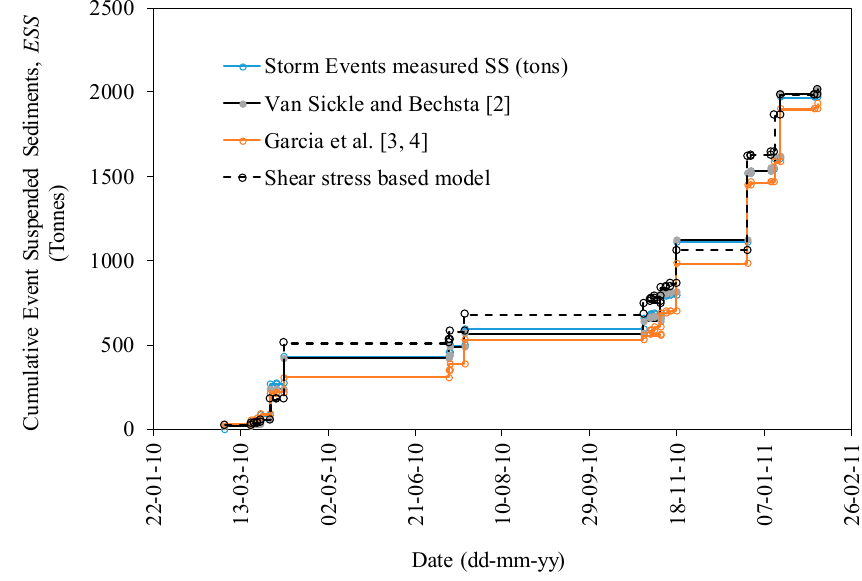
Figure 12. Cumulative event suspended sediment (ESS) for the storm events for the study period.